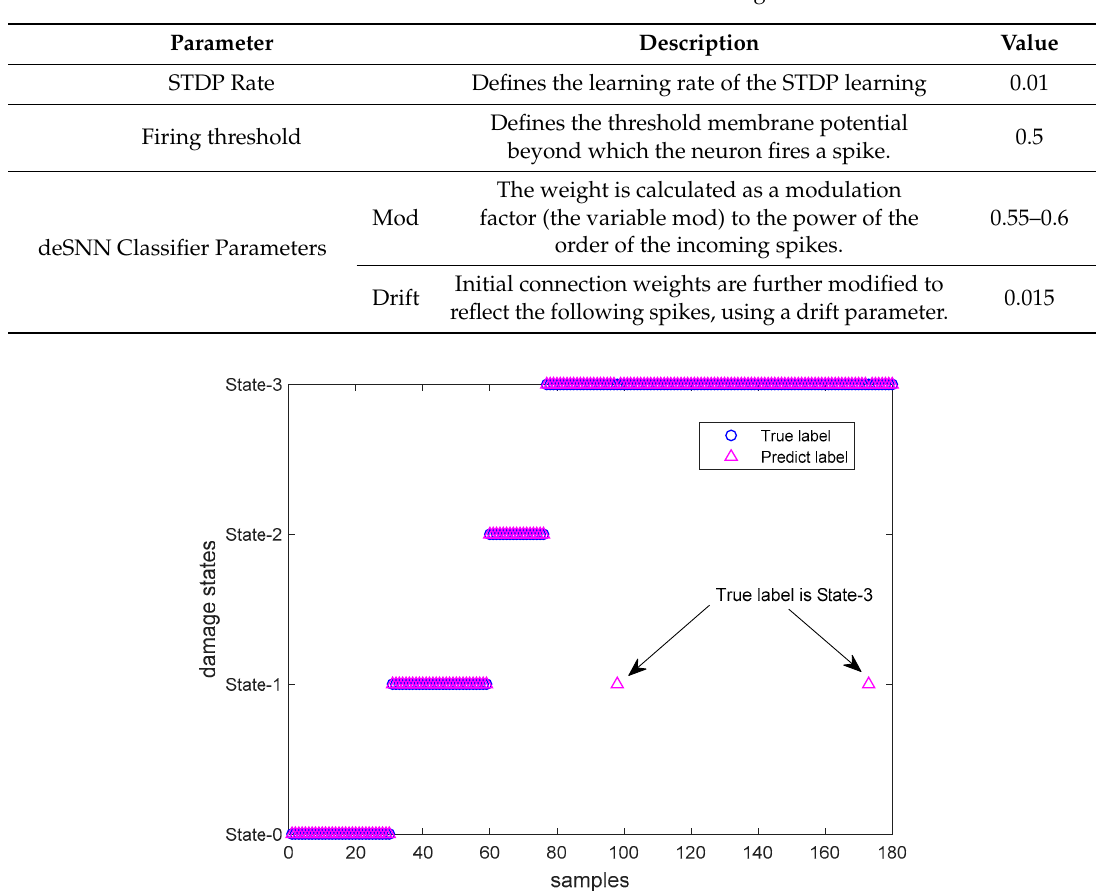
Figure 7. Classification result by using NeuCube (raw data).